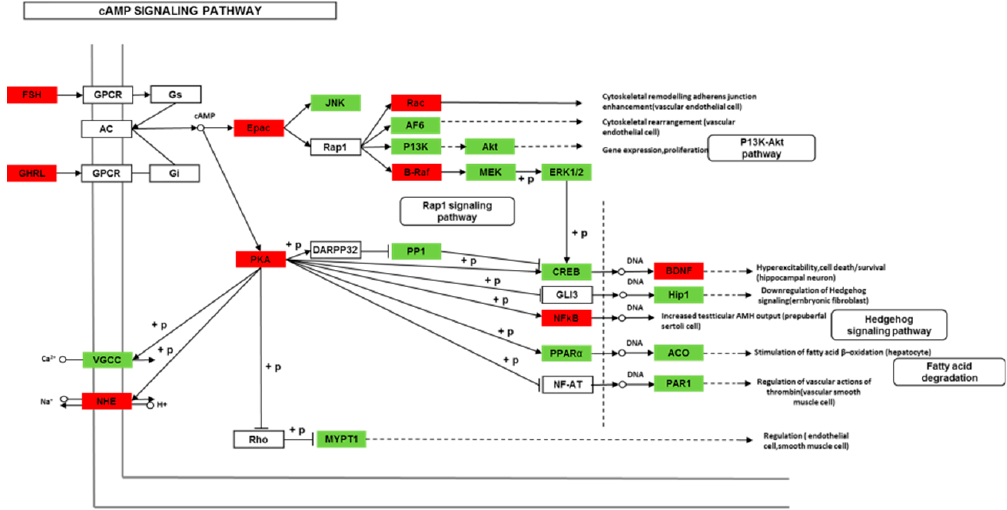
Figure 5. Di ff erentially expressed genes in the cyclic AMP (cAMP) signaling pathway between mandarin fish in the control group (CG) and the learning group (LG) from a transcriptome analysis. The colors of rectangles were shaded according to the di ff erent expression (red: The mRNA expression levels of fish in Group LG were significantly higher than those in Group CG (FDR ≤ 0.001, the absolute value of log2 (Ratio) ≥ 1); green: The mRNA expression levels of fish in Group LG were significantly lower than those in Group CG (FDR ≤ 0.001, the absolute value of log2 (Ratio) ≥ 1)).